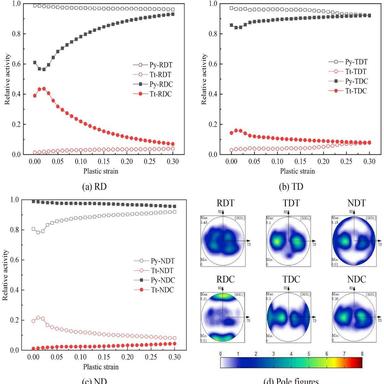
Relative activities of individual deformation modes under different loading conditions when only Tt and Py are activated in the thought experiment, and the predicted pole figures after 20% tension/compression along six directions. Tt was activated largely at the beginning under RDC, TDC and NDT, which causes a sudden rotation of nearly 90� in the grain orientation.